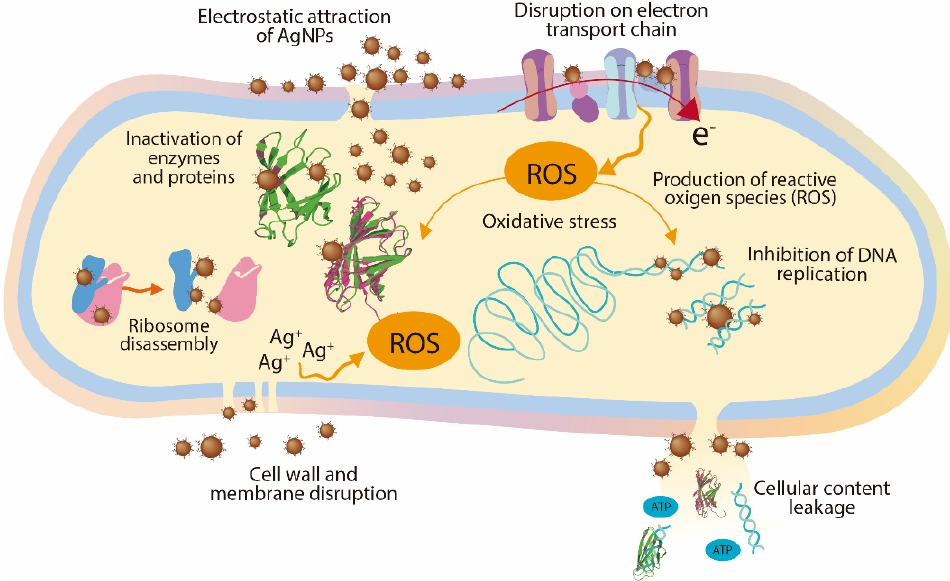
Figure 5. Antimicrobial mechanisms of AgNPs.